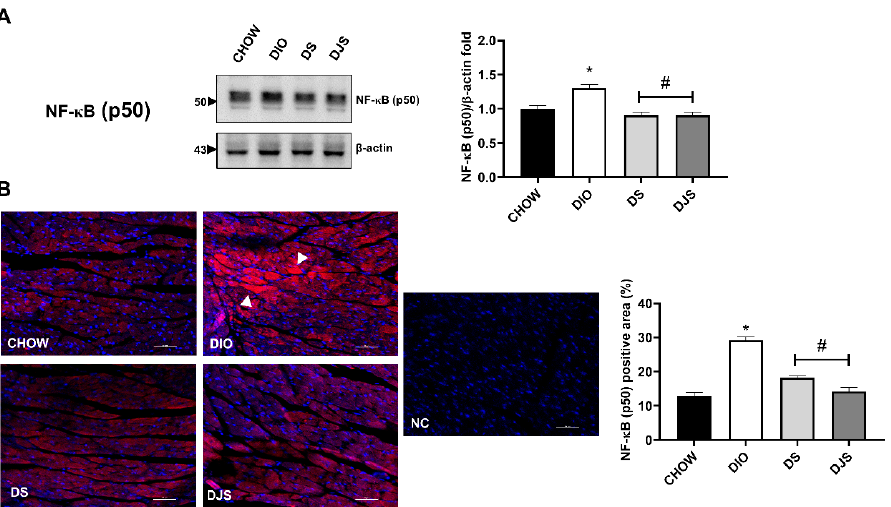
Figure 4. Measurement of nuclear factor kappa-light-chain-enhancer of activated B cells subunit p50 (NF- κ B p50). ( A ) Cardiac lysates from rats were immunoblotted using specific anti NF- κ B (p50). Graph shows the ratio of densitometric analysis of bands and β -actin expression used to normalize the data, taking CHOW rats as a reference group; ( B ) Confocal image of representative immunofluorescent staining for NF- κ B (p50) in the heart and quantification expressed as percentage (%) of NF- κ B (p50) positive area. Magnification 10 × zoom 3. Scale bar 10 µ m. NC, Negative control. Arrowheads indicate the more immunoreactive cardiomyocytes. CHOW rats ( n = 8), fed with standard diet; DIO rats ( n = 9), fed with high-fat diet; DS ( n = 12), DIO rats supplemented with tart cherry seeds; DJS ( n = 9), DS rats supplemented with tart cherry juice. Data are mean ± SEM. * p < 0.05 vs. CHOW rats; # p < 0.05 vs. DIO